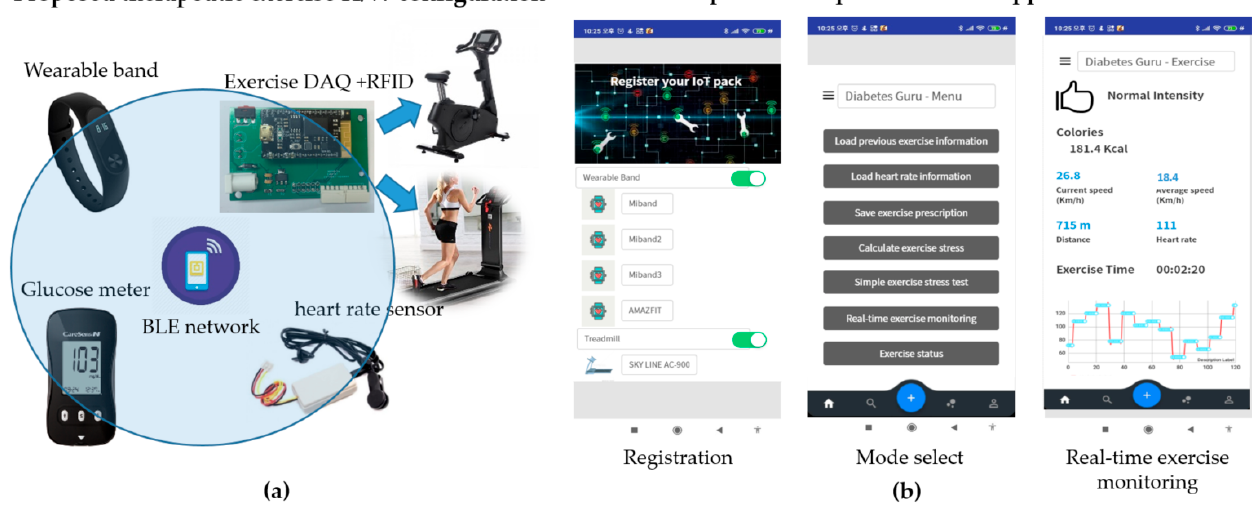
Figure 2. The proposed therapeutic exercise platform: ( a ) Hardware configuration; ( b ) Smartphone application of the pro- posed platform.